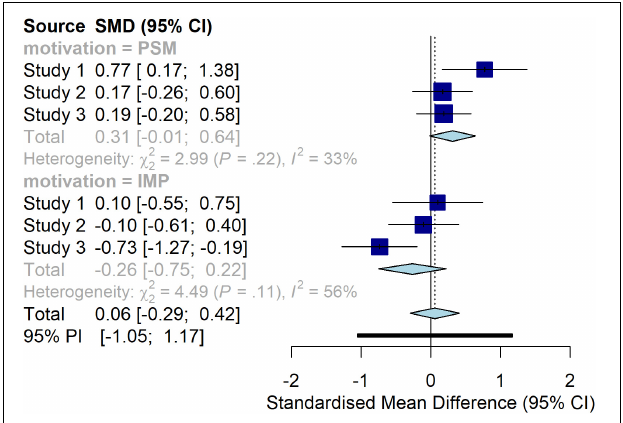
FIGURE 7 | Forest plot of initial act of support according to the motivation